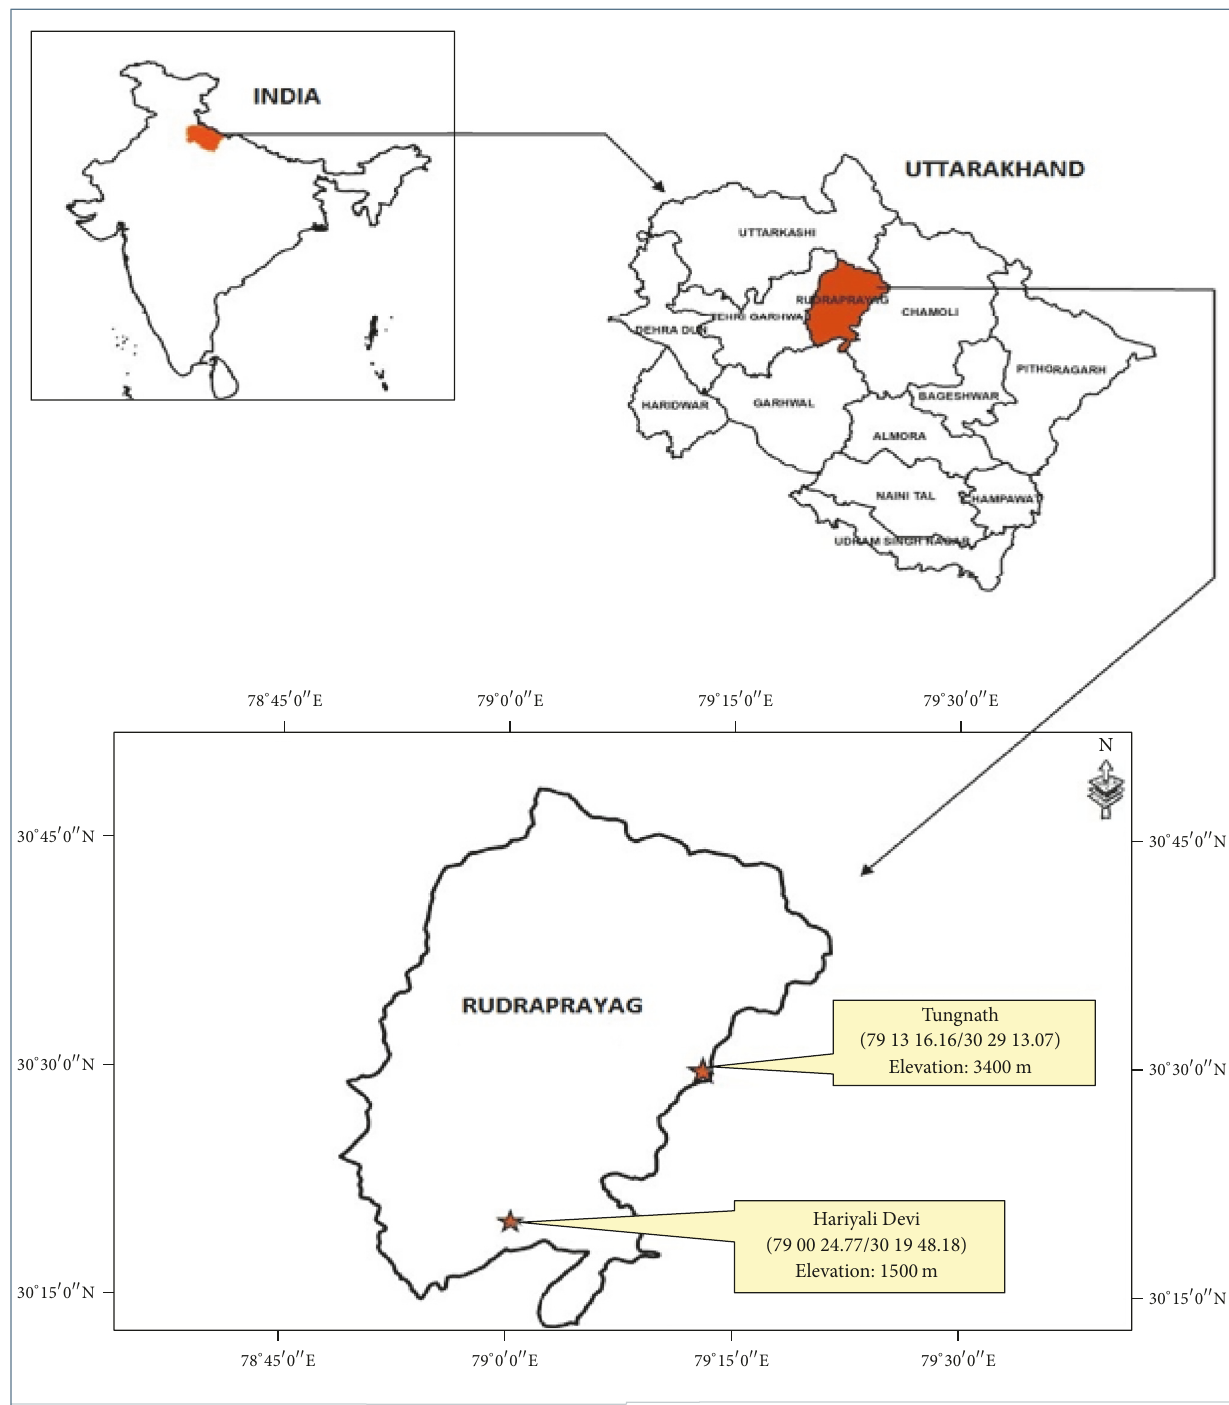
Figure 1: Location of the Hariyali Devi and Tungnath sacred groves in